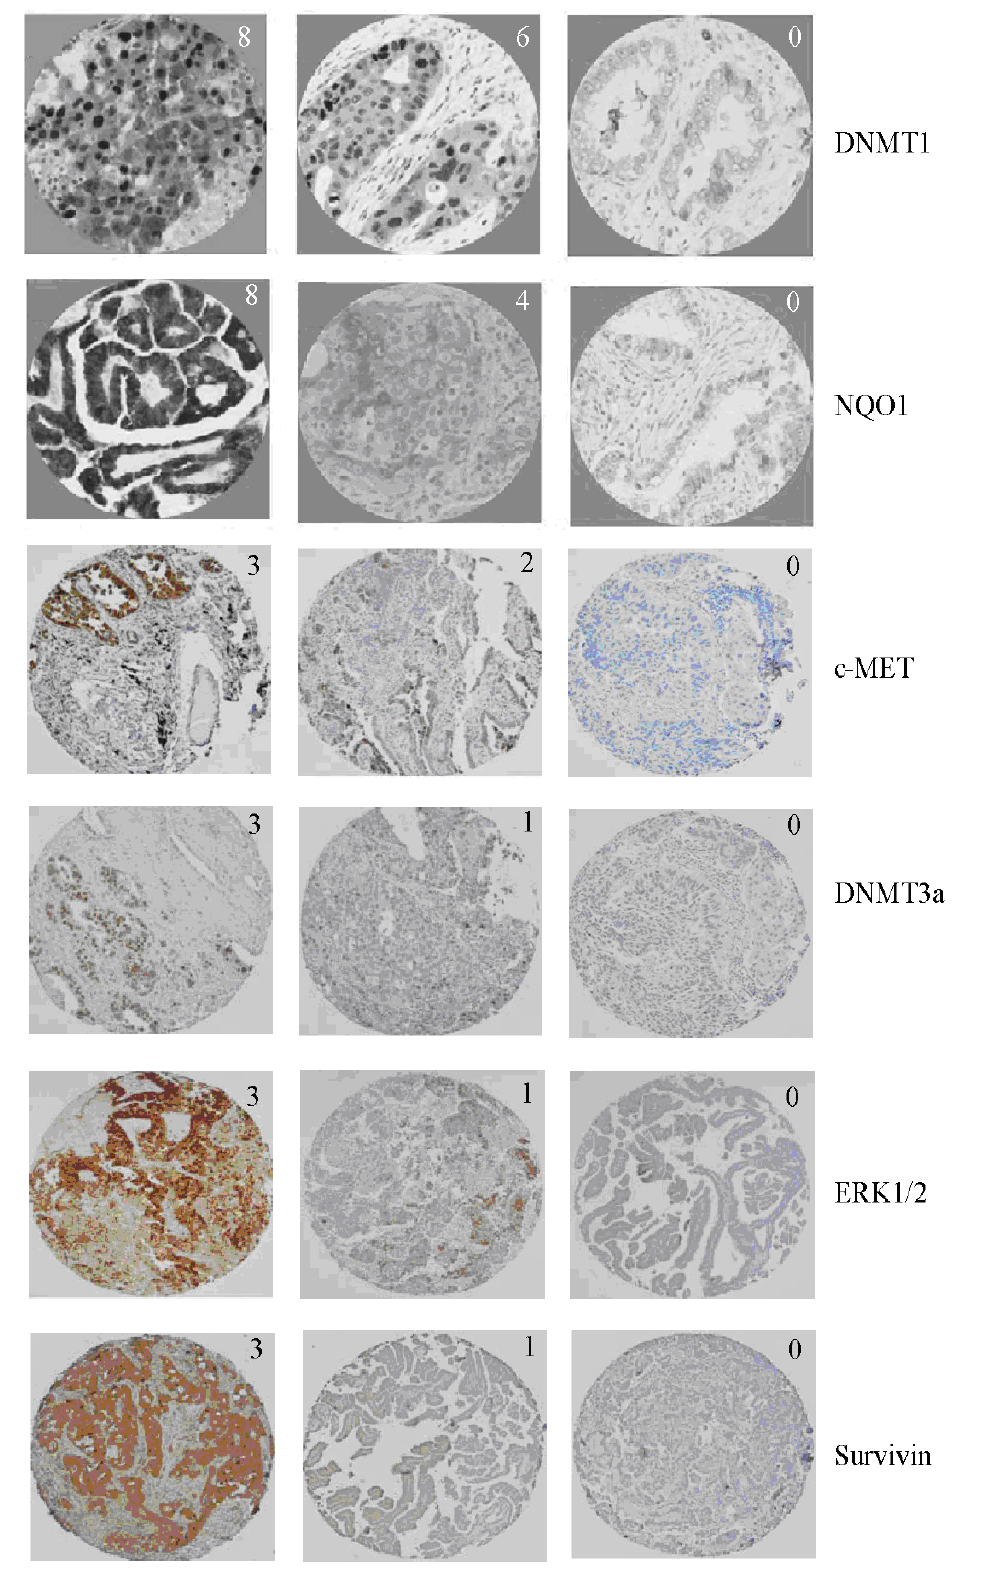
Figure 2. Representative immunohistochemistry images of proteins with different Allred scores investigated in this study. The values on the top right corner of each image represent Allred score for that